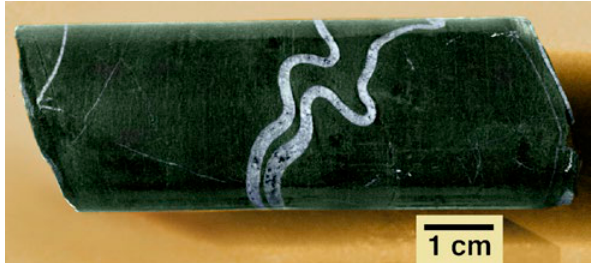
Figure 73. These two diverging and ‘wandering’ ptygmatic quartz veins in chloritic shales were intersected in drilling at Orlando Mine Tennant Creek, NT. The veinlets were apparently intruded when the diagenetic sediment was water-rich, soft and carrying at least some of the overburden load by hydraulic pressure. Small dif- ferential pressures appear sufficient to intrude the fluid precursor silica gel.